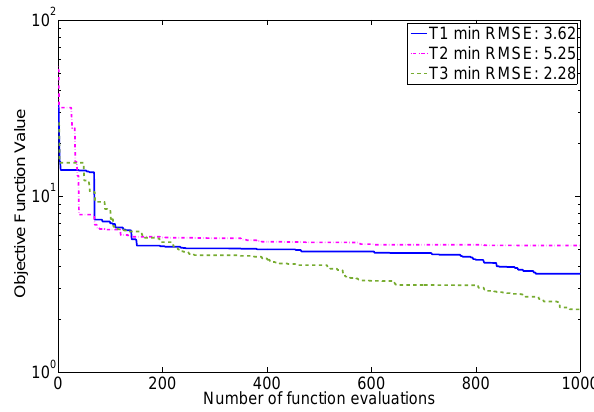
Figure 2. Progress plot that shows the development of the best ob- jective function value found vs. the number of function evaluations for the pseudo data case with d = 11 parameters for optimization trials T1, T2, and T3. The legend shows the lowest RMSE value found in each trial. Table 5. Default and optimized parameter values of optimization trial T3 and parameter values for the point CP that was sampled during the same optimization trial and that is closer to the default point, but that has a worse objective function value (11-dimensional pseudo data case). Bold numbers indicate the parameters for which CP is closer to the default value than T3 (but CP has a worse objec- tive function value).